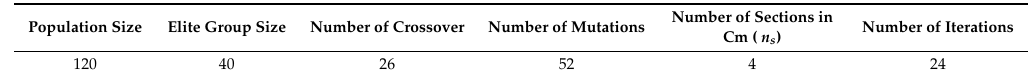
Table 2. Tuned parameters of GA.